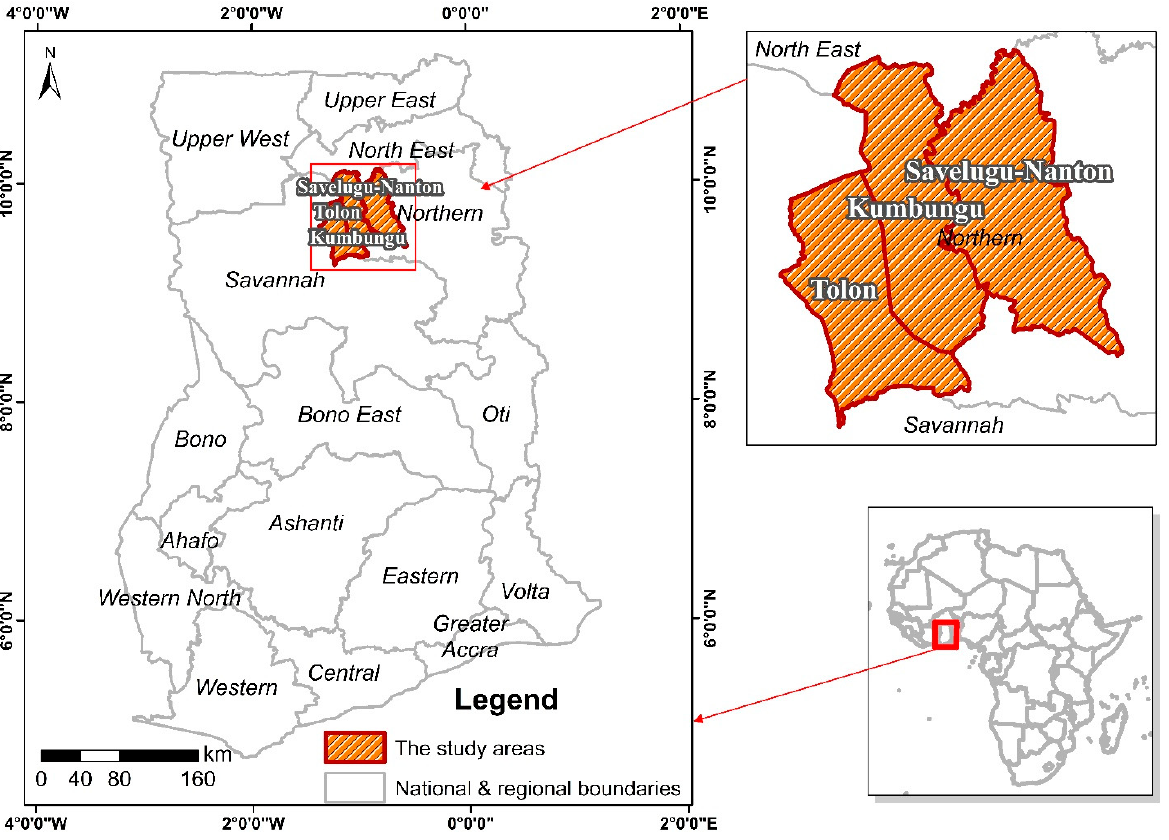
Figure 1. Map showing study sites in northern Ghana, West Africa. The annual average rainfall ranges from 650 mm to 1600 mm (Figure 2). The district is characterized by high temperatures, with an average of 34 ◦ C. The maximum temperature could rise to as high as 42 ◦ C, with a minimum of 19 ◦ C.